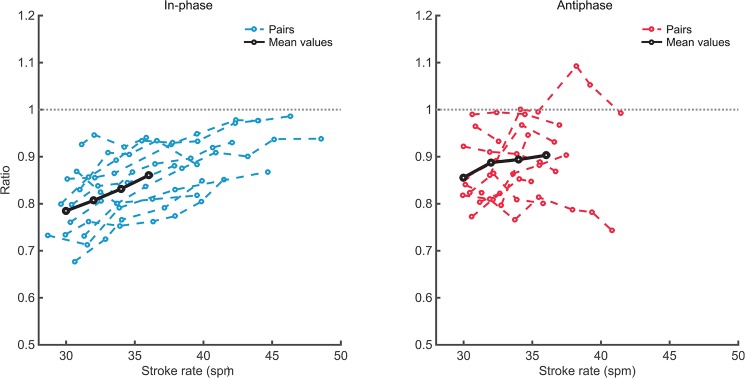
Drive-recovery ratio.
Ratio for individual rowers in in-phase (left panel) and antiphase crew coordination (right panel), depicted against performed stroke rates for all eleven dyads. Note that for clarity of presentation, we only plotted the ratios of each stroke rower (i.e. rower 1). Black lines indicate the means over the sixteen rowers as used in the RM ANOVA for stroke rates 30–36.